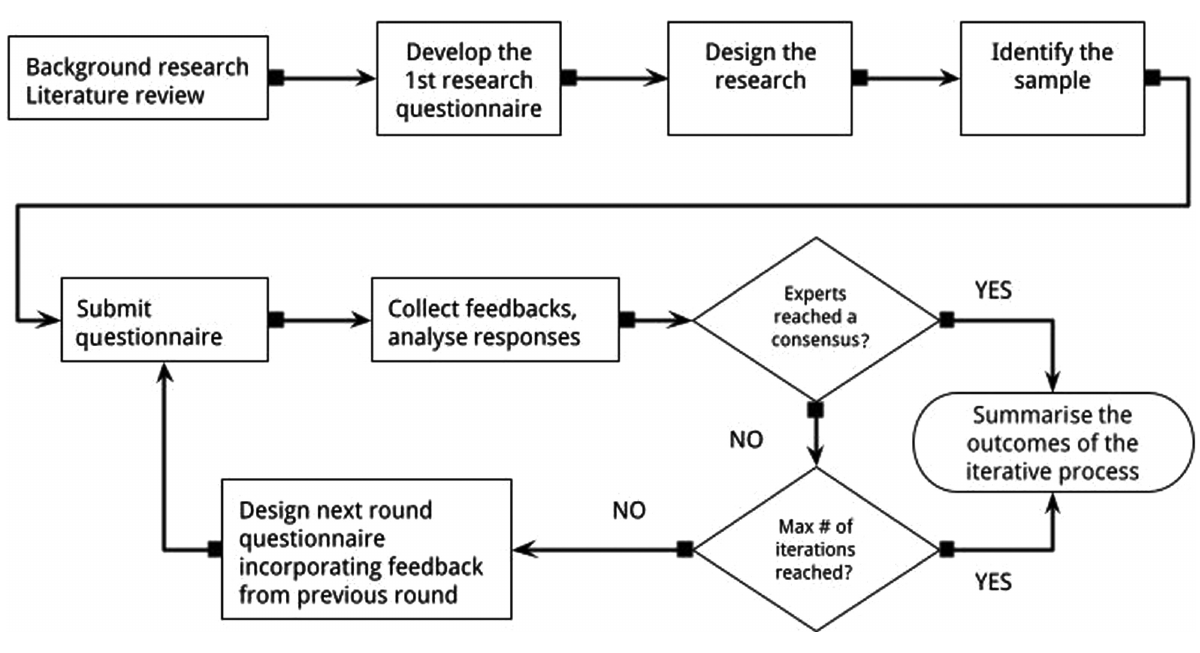
Figure 1. Summary workflow of the Delphi method adopted for this research (Source: Adapted from Skulmoski et al., 2007: